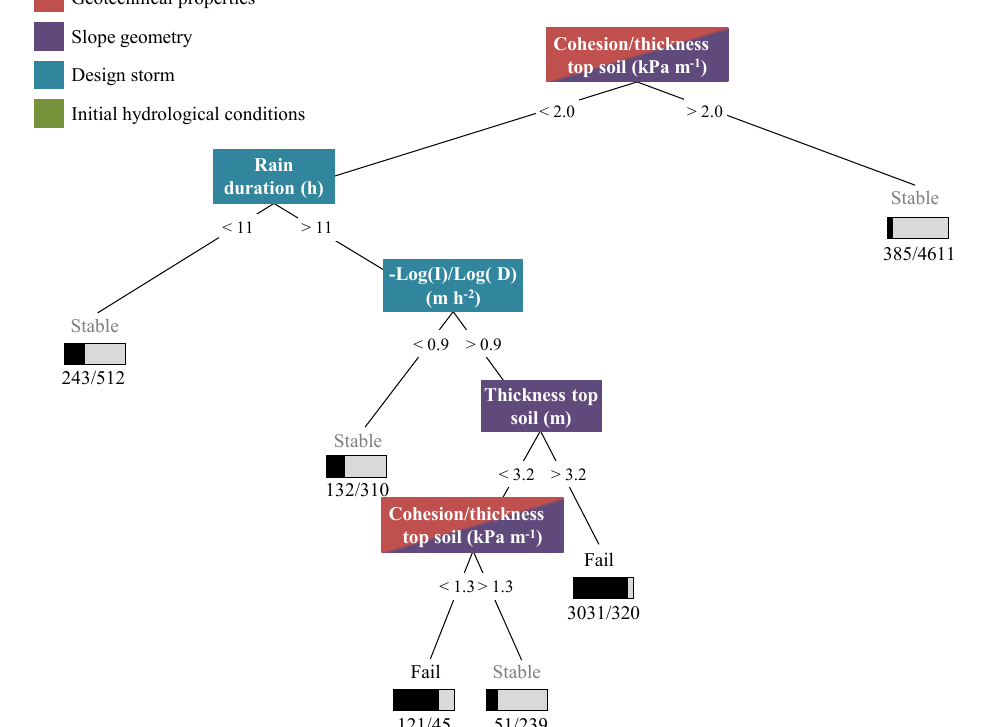
Figure 9. Classification tree of slope response, when adding two auxiliary variables: the ratio between effective cohesion and thickness of topsoil, and the negative ratio between the logarithm of rainfall intensity and the logarithm of rainfall duration. The bar under each leaf shows the proportion and total number of simulations leading to slope failure (black bar, left-hand number) or a stable slope (grey bar, right-hand